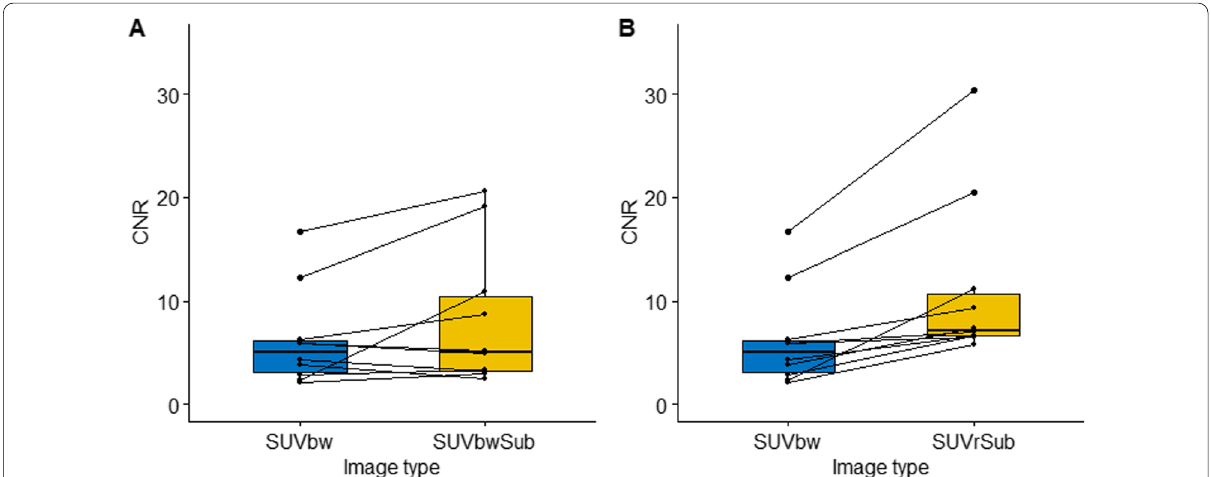
Fig. 6 Contrast to noise for original Met-PET compared with both subtraction images. Linked box plots show the CNR using the SUVbw (original) images compared with the subtraction images generated from a the two SUVbw images and b the two SUVr [cerebellum]